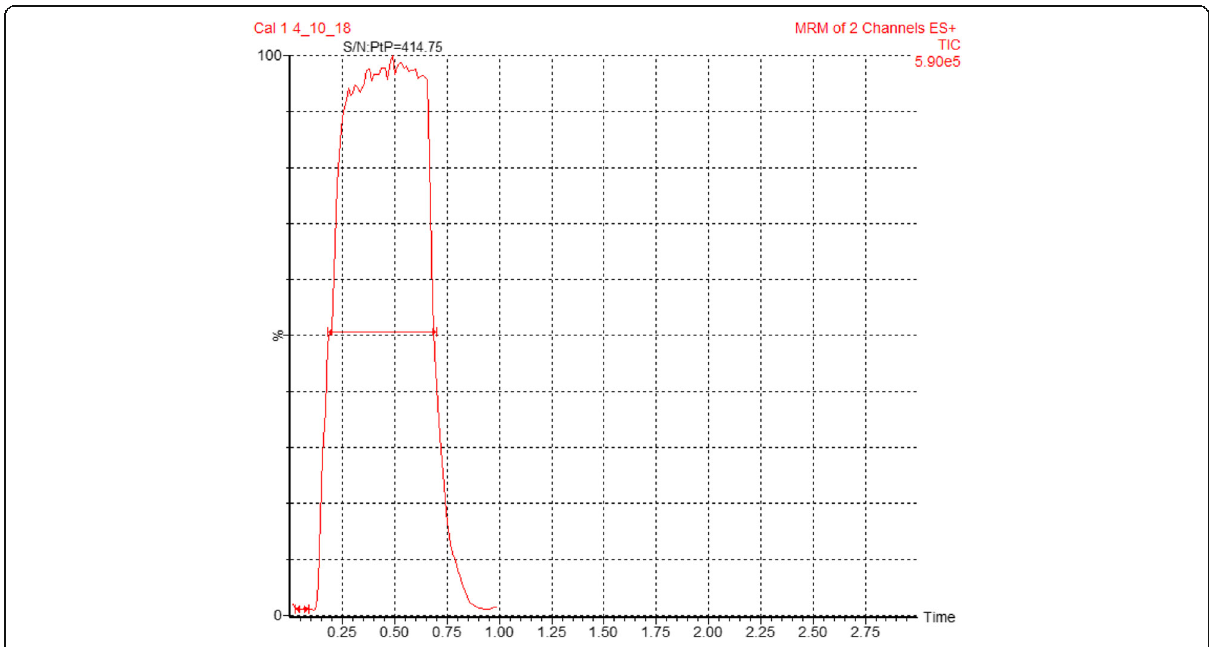
Fig. 2 A chromatogram of the calibrator A showing the signal to noise ratio (S/N)